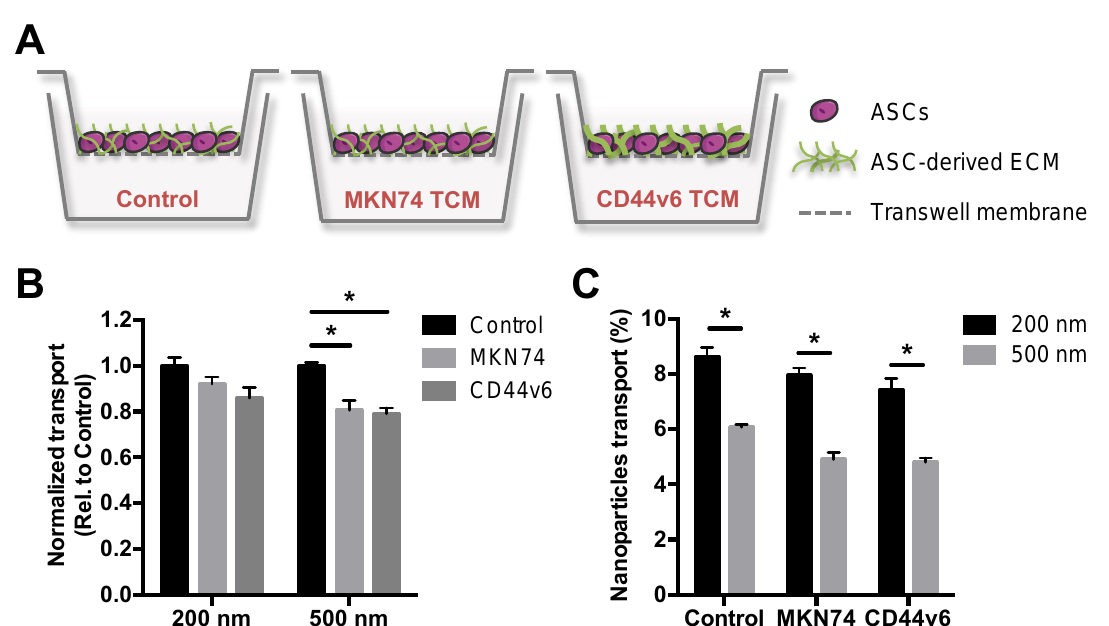
Figure 2. CD44v6 and MKN74 GC-mimetic stroma remodeling hinders the transport of PNPs in a size-dependent manner. ( A ) Schematic representation of in vitro gastric cancer (GC) stroma model showing adipose stromal cell (ASC)-derived extracellular matrix (ECM) treated either with control media or tumor conditioned media (TCM) from both GC cells (MKN74 TCM and CD44v6 TCM). ( B ) Quantitative analysis of 200 and 500 nm PNPs transport through in vitro GC stroma models relative to control. * p < 0.05. ( C ) Percentage of 200 and 500 nm PNPs that translocate the in vitro GC stroma models after 2 h of incubation. * p < 0.05.